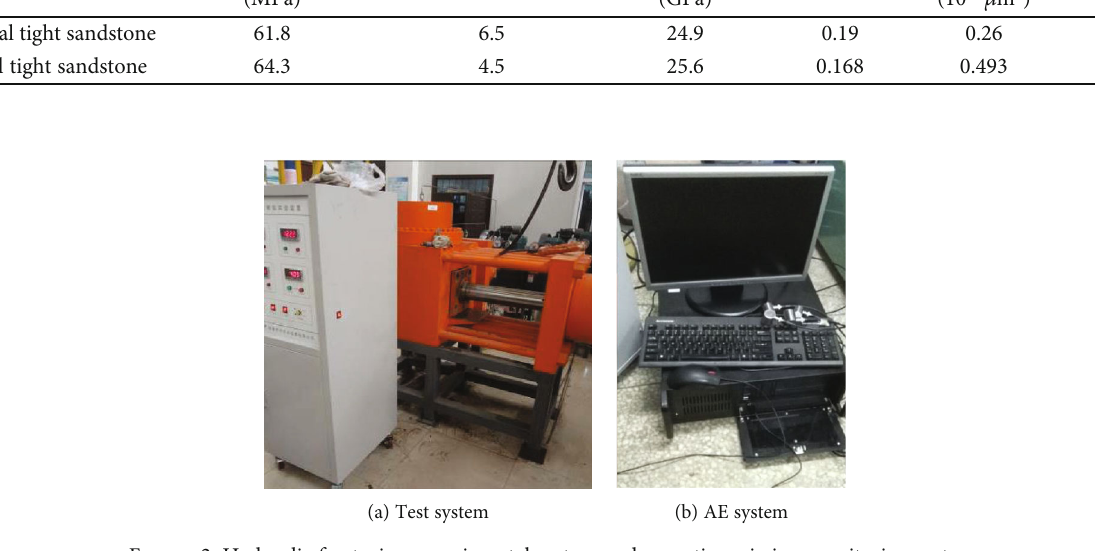
Figure 2: Hydraulic fracturing experimental system and acoustic emission monitoring system.